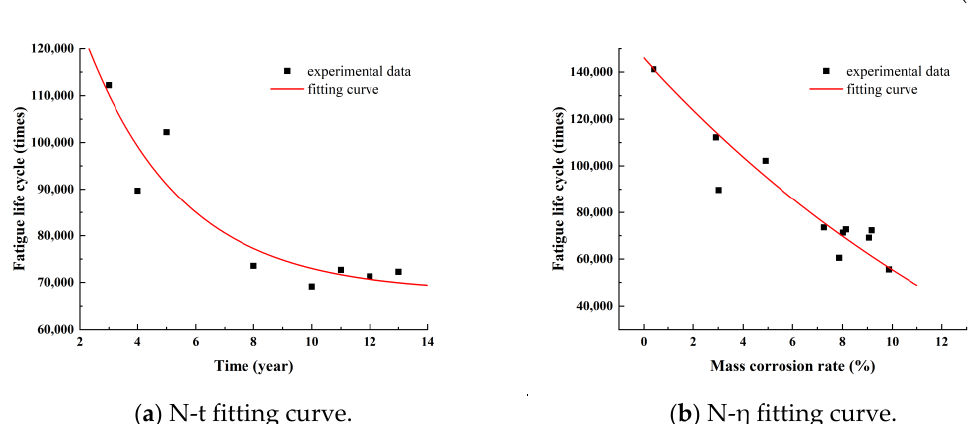
Figure 8. Curve of fatigue cycle numbers with time(t)/corrosion rate ( η ).